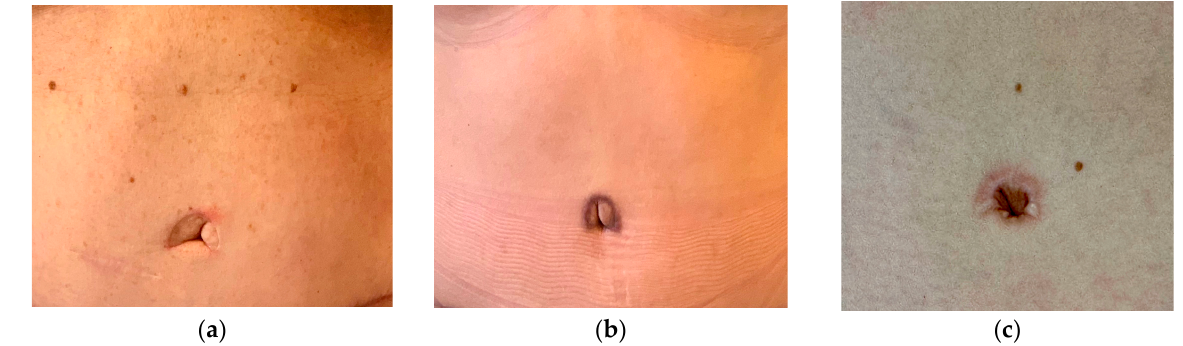
Figure 1. Conventional umbilicoplasty with an inferior flap from the abdominal wall in DIEP-flap reconstructions. The flap is secured to the base of the umbilicus at the rectus sheath. ( a ) Inconspicuous scar but protrusion of the umbilicus; ( b ) periumbilical scar visible due to pigmentation. ( c ) Hypertrophic scar after secondary healing with a darker color in the umbilicus.